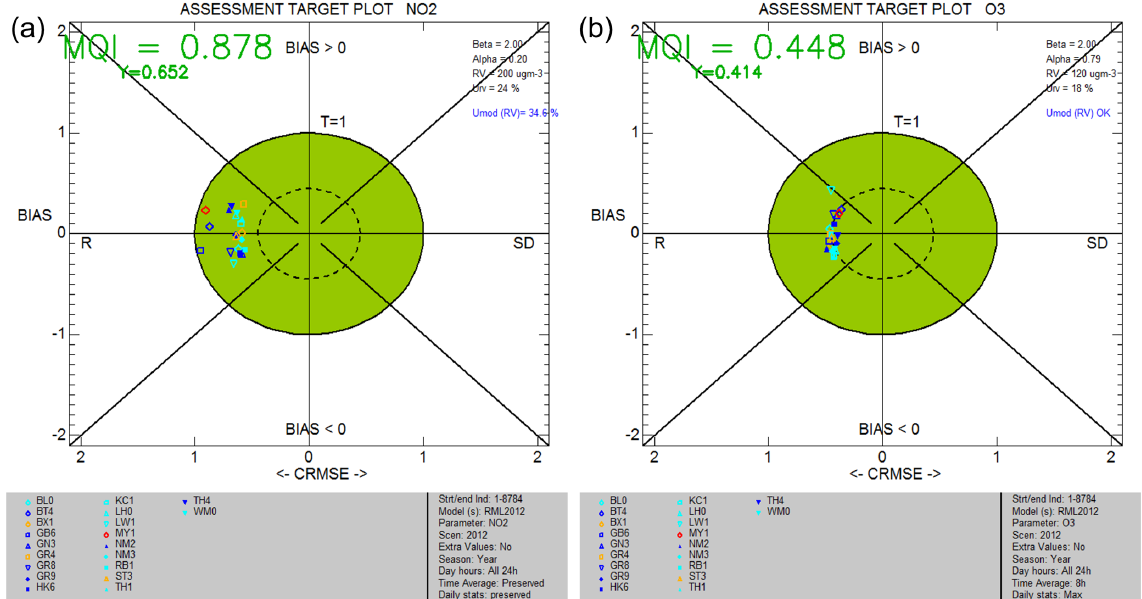
Figure A4. Model assessment target plots for NO 2 (a) and O 3 (b) for coupled system outputs. Each symbol represents a single station and the distance between the origin and the symbol corresponds to the MQI for that station; the ordinate and abscissa correspond to the bias and CRMSE respectively. Good model performance is indicated by points within the green